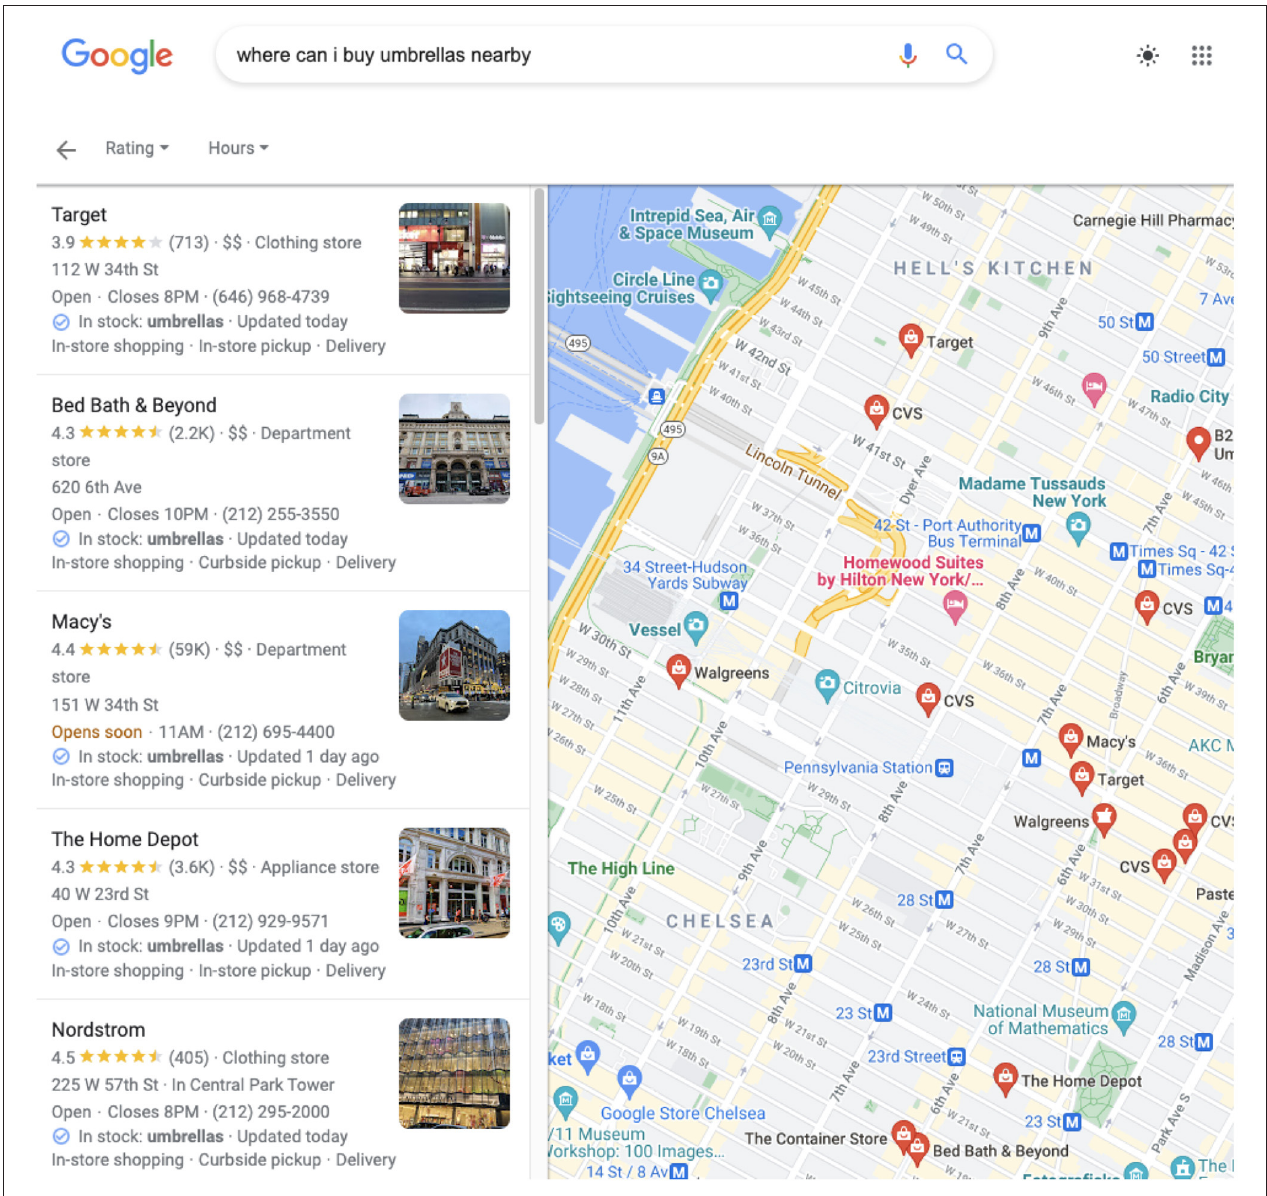
FIGURE 1 | Google Maps local shopping search results for umbrellas in NYC shows stores that sell them.